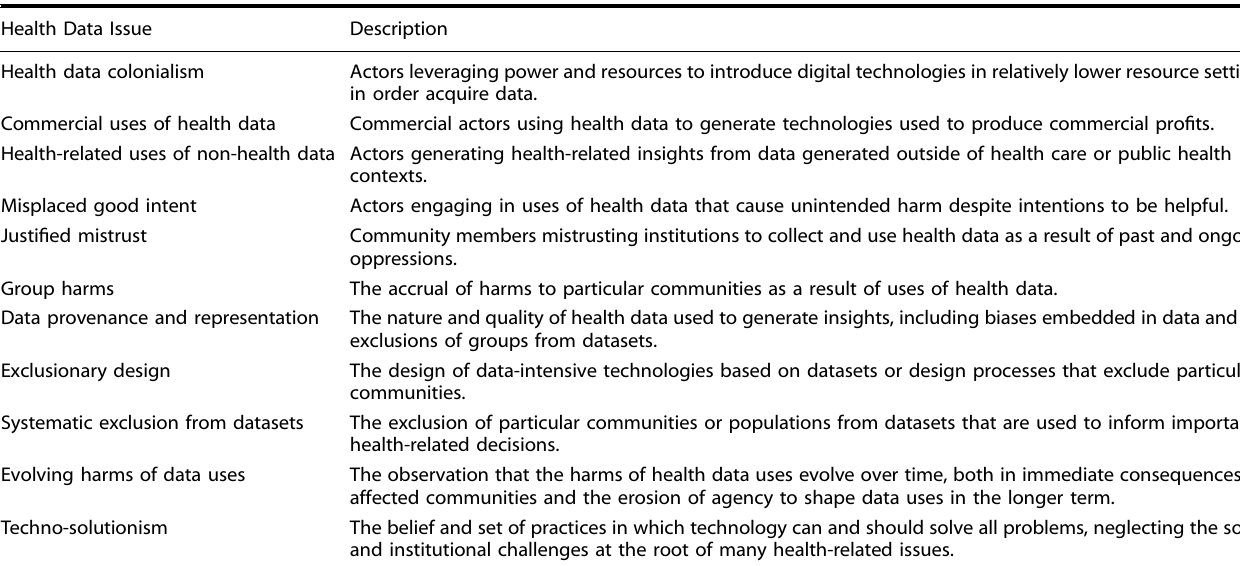
Table 1. Urgent issues for health data